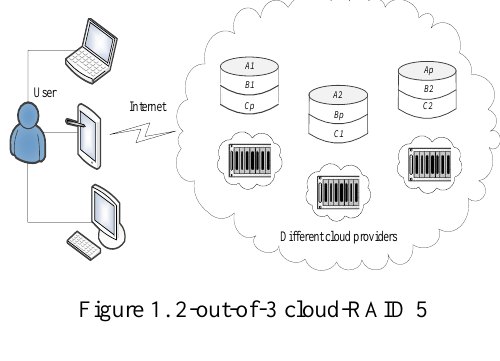
Figure 1. 2-out-of-3 cloud-RAID 5